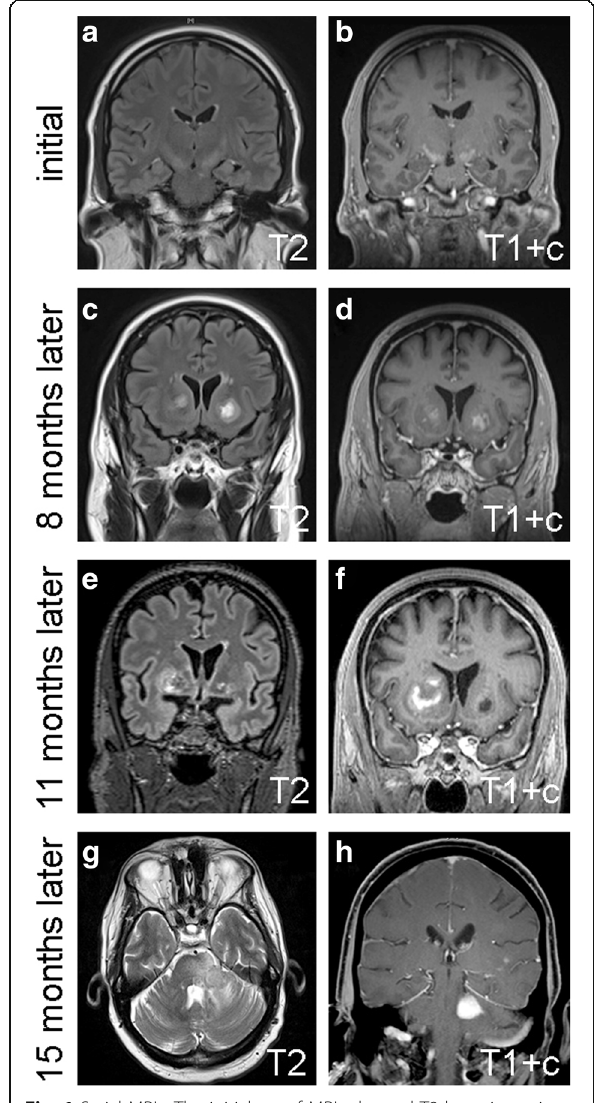
Fig. 1 Serial MRIs. The initial set of MRIs showed T2 hyperintensity and some contrast enhancement in the bilateral internal capsules ( a , b ). Eight months later, a second set of MRIs showed new enhancing lesions in the bilateral basal ganglia ( c , d ). Eleven months after initial presentation, the right basal ganglia lesion appeared to grow, whereas the lesion in the left basal ganglia diminished ( e , f ). In the final set of MRI, 15 months after initial presentation, the right basal ganglia lesion was unchanged (not shown), and a new enhancing mass appeared in the left middle cerebellar peduncle ( h ). c =